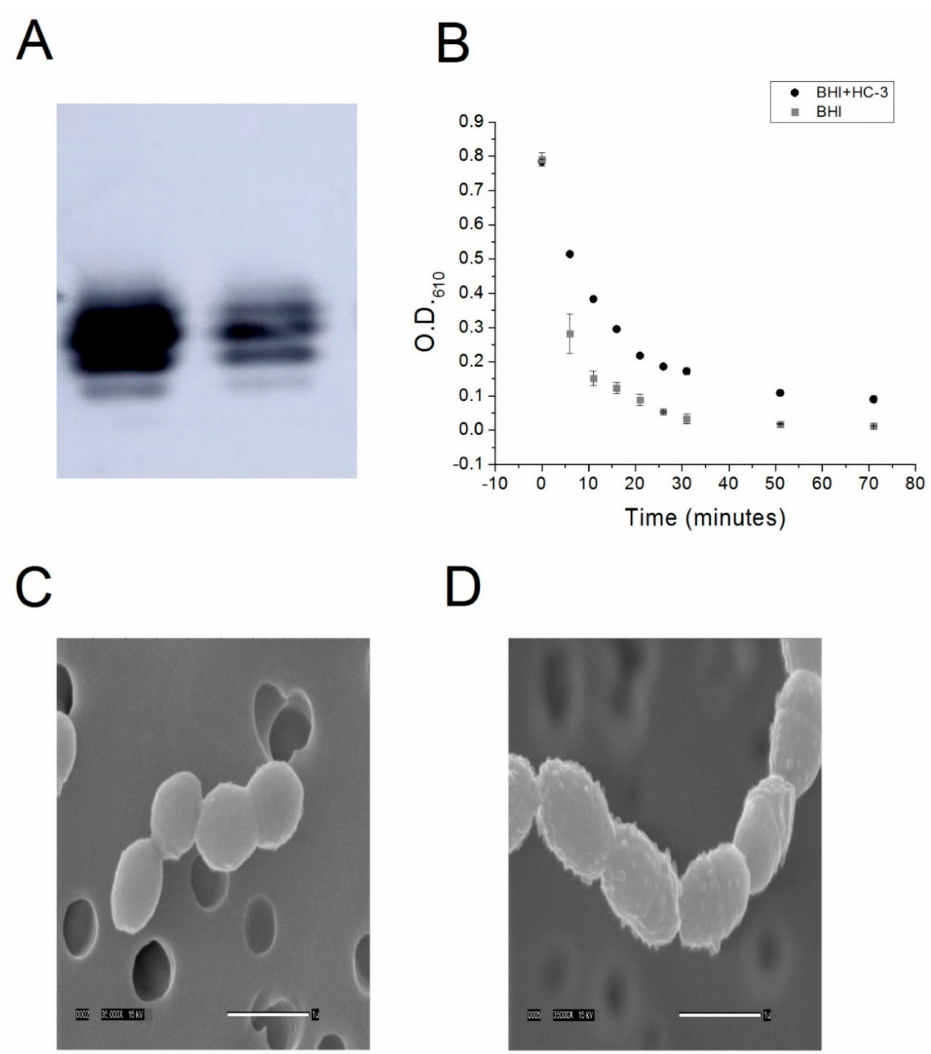
Figure 3. ( A ) Western blot detection of lipoteichoic acid from cell extracts of either control R6 cells (left lane) or R6 cells cultured in the presence of 2.7 mM HC-3 (right lane).The intensity of the signal drops dramatically (2.4 × ) in the case of treatment with HC-3. ( B) Cell lysis of cells that had been grown in either BHI alone or BHI + HC-3 were then exposed to a deoxycholate-containing solution. Cell lysis was monitored by measuring the optical density of the solution at 610 nm. ( C,D ) Scanning electron micrographs at 35,000 × magnification of untreated S. pneumoniae cells and ( C ) and cells treated with HC-3 ( D ). The smooth cell surface changes into a bumpy surface upon treatment with HC-3, indicating that the cell wall structure has been